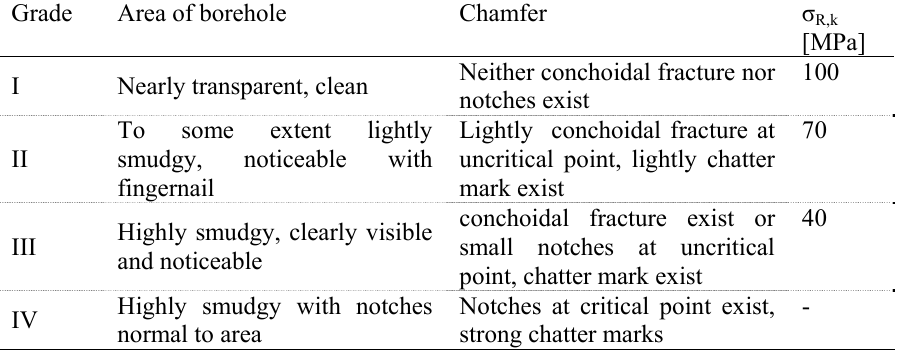
Table 2: Quality of